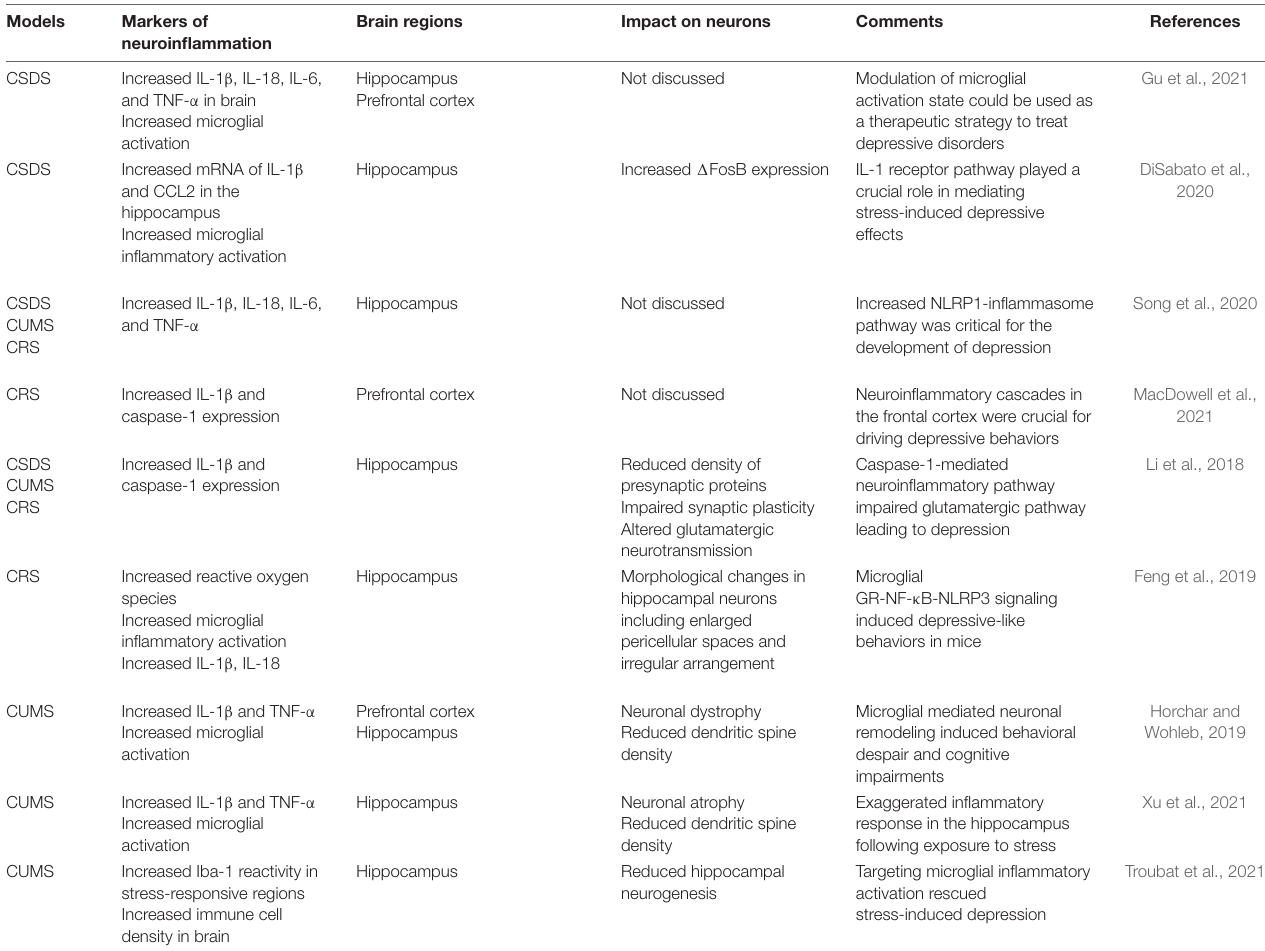
TABLE 1 | Neuroinflammatory markers in animal models of